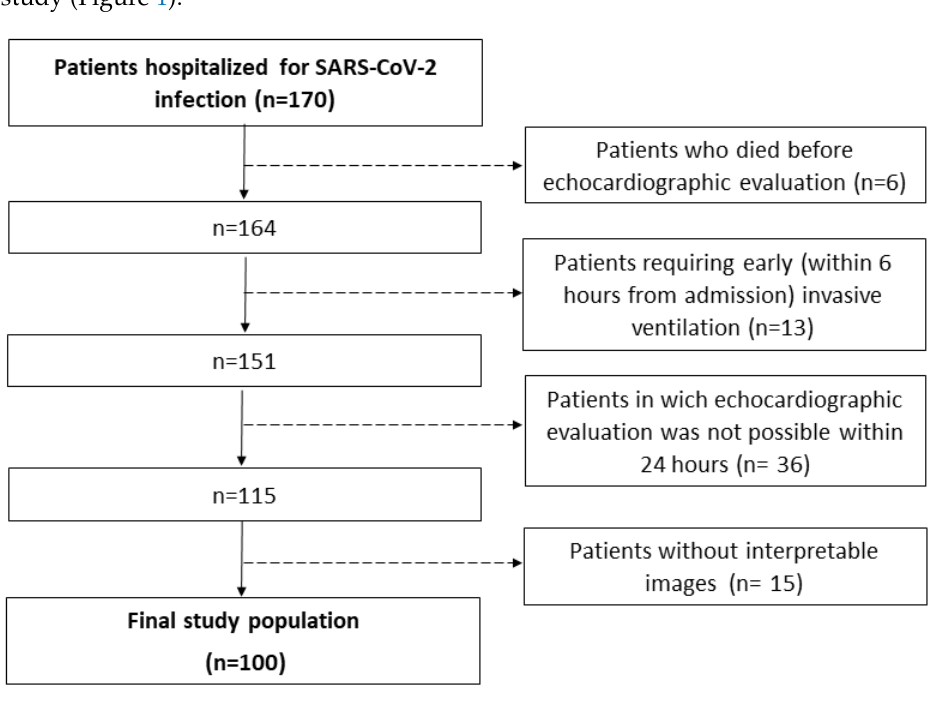
Table 1. Demographic/clinical characteristics of patients with COVID-19, in the overall population and according to ePLAR values at baseline.